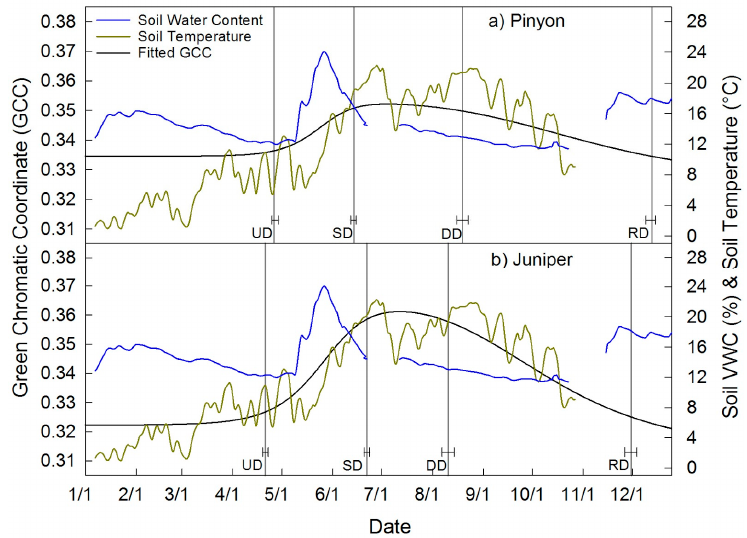
Figure 6. Seasonal course of GCC and phenophase dates for ( a ) pinyon and ( b ) juniper plotted with 3-day average daily soil temperature at 5 cm and soil volumetric water content (VWC). Note data gaps in soil VWC were caused by datalogger malfunction. Pinyon and juniper had a similar growing season. However, there was greater seasonal variation in greenness for juniper and a close tracking of green up with soil temperature in juniper.